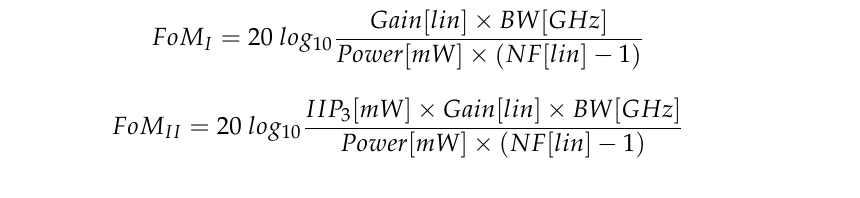
Table 1. Performance comparison with respect to simulated results.